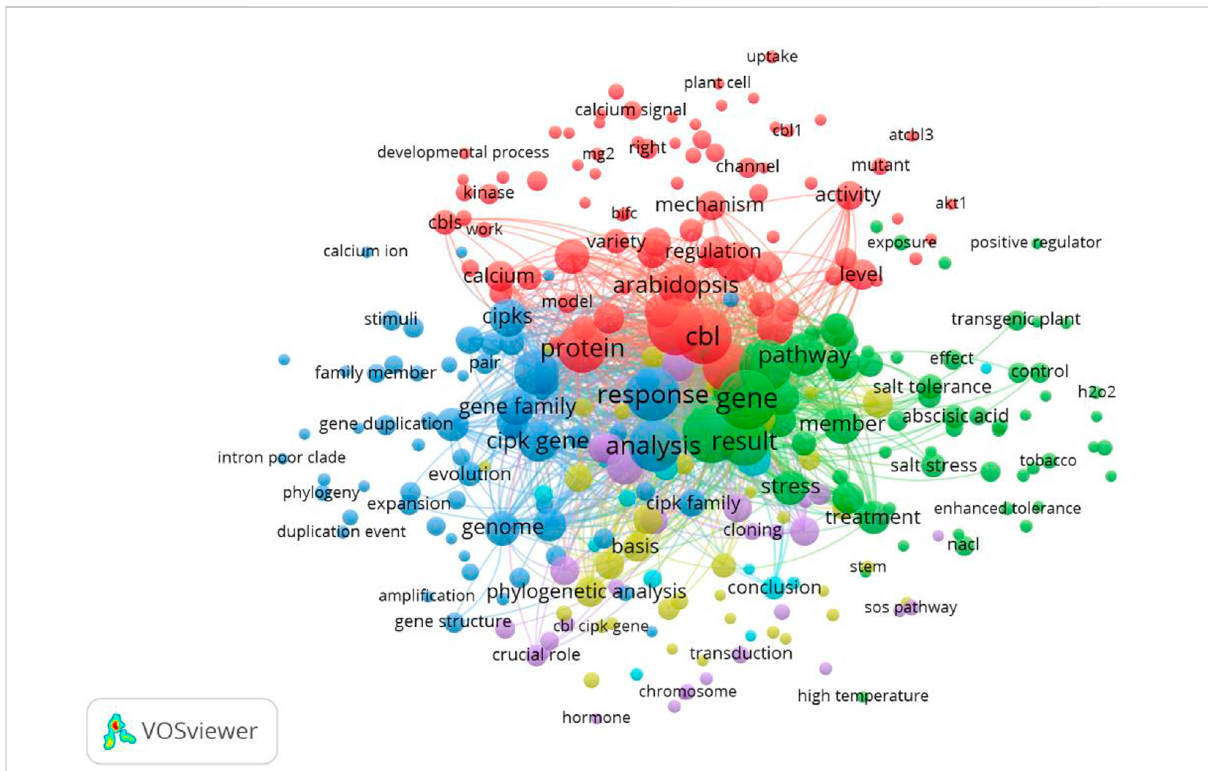
FIGURE 12 Term co-occurrence map. A total of 2,856 terms were extracted from the titles and abstracts. The mapped network is sketched using a minimum occurrence of 3. A total of 300 terms were